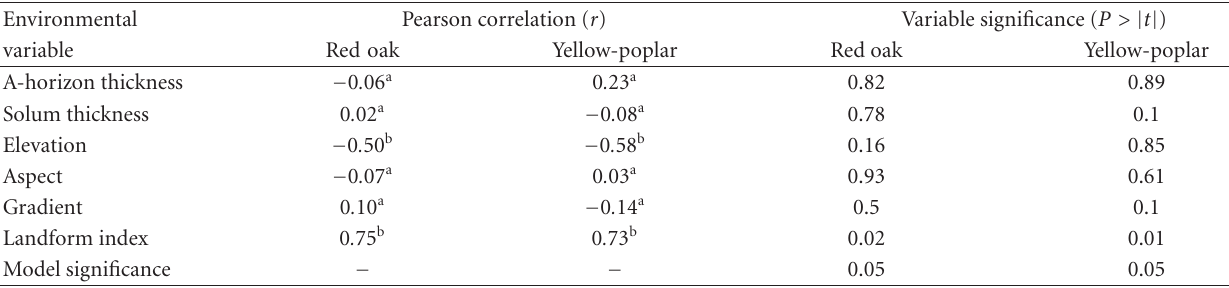
Table 2: Pearson correlation coe ffi cients ( r ) of environmental variables with site index and overfitted regression significance levels ( P > t ) for a site index model with all independent environmental variables by species for stands sampled in the Southern Appalachian Mountains of North Carolina, USA.